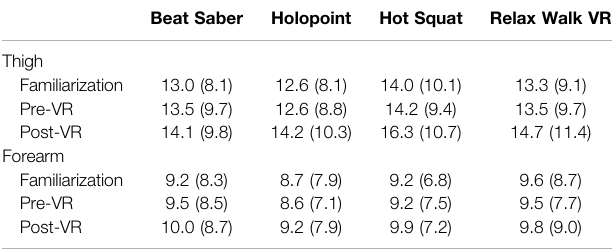
TABLE 3 | Means and standard deviations (SD) for Pressure Pain Thresholds across Game, Time, and Body Site. Beat Saber Relax Walk VR